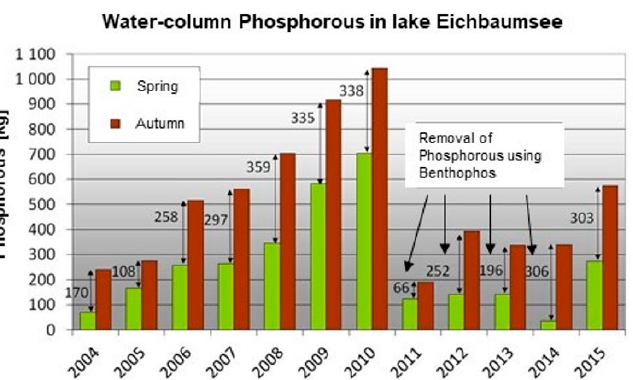
Figure 2. Phosphorous content of Lake Eichbaumsee in spring and autumn between 2004 and 2015. Numbers with arrows indicate the phosphorous increase (kg) between spring and autumn. The application of Bentophos ® in the winters 2011 through 2013 did not lead to a long-term reduction of the lake phosphorous content (modified from